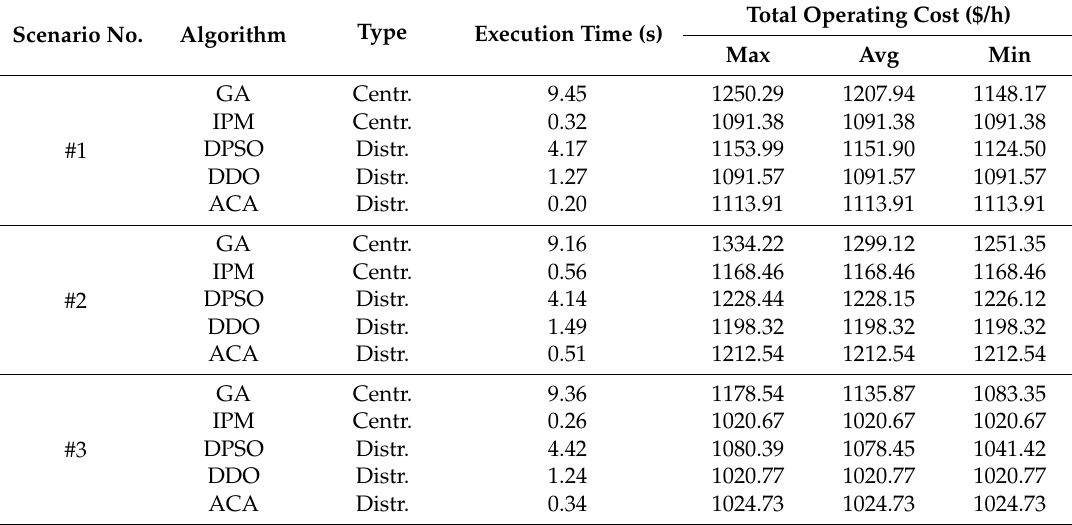
Table 4. Comparison results obtained by five algorithms under different scenarios in 100 runs.